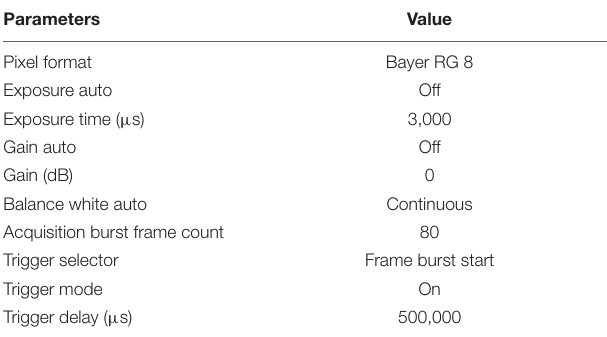
TABLE 1 | Basler acA4112-20uc camera parameters.